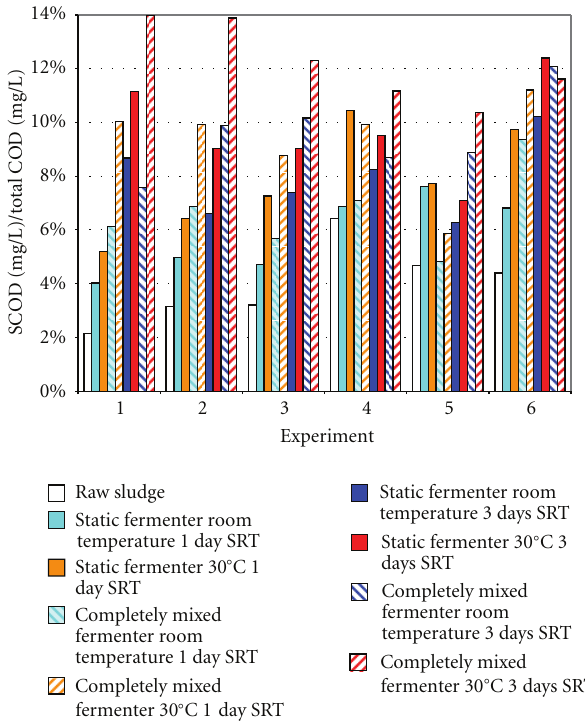
Figure 1: SCOD yield for each experiment.